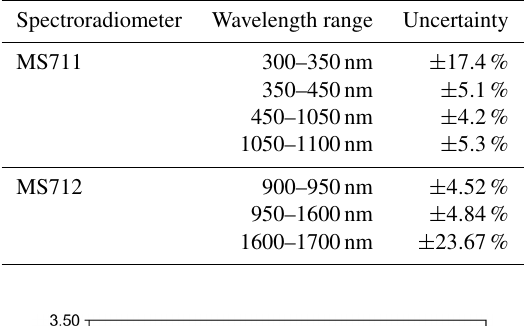
Table 3. Calibration uncertainty of MS711 and MS712.